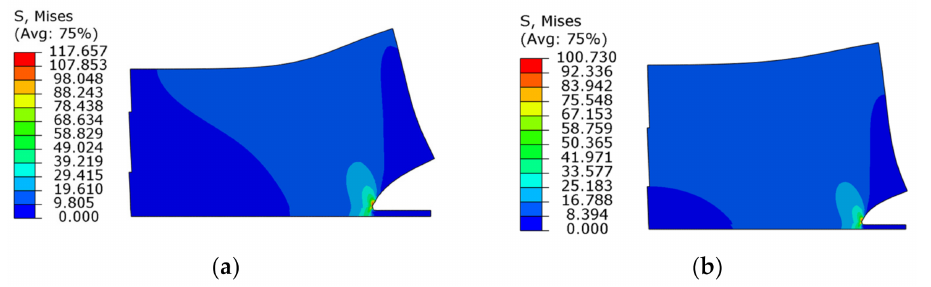
Figure 10. The von Mises equivalent stress distribution in the crack tip with different solder thick- nesses: ( a ) 20 µ m; ( b ) 30 µ